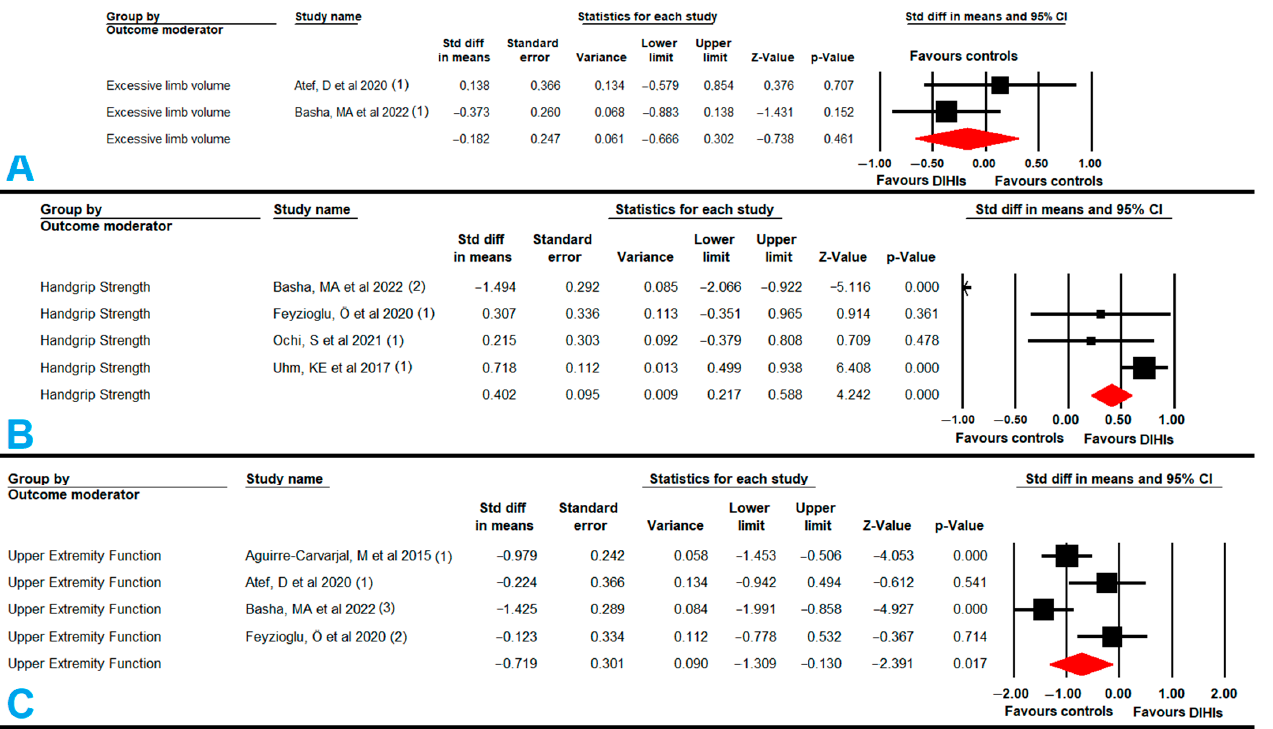
Figure 4. Forest plot of the effect of digital and interactive health interventions on excessive limb volume ( A ), handgrip strength ( B ), and upper extremity function ( C ) [55,56,62,65,68,73].